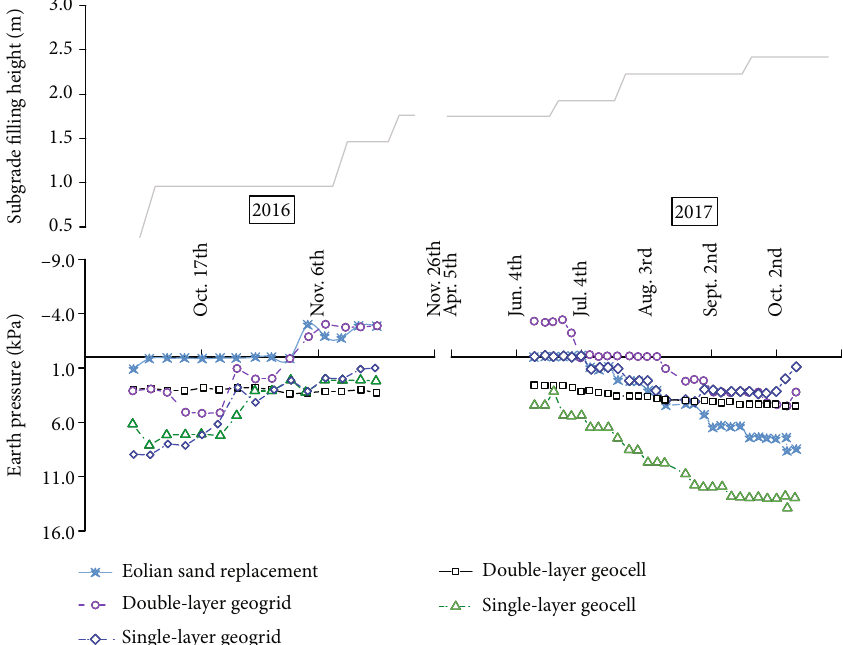
Figure 6: Soil pressure-time curve of the subgrade in the left shoulder base.